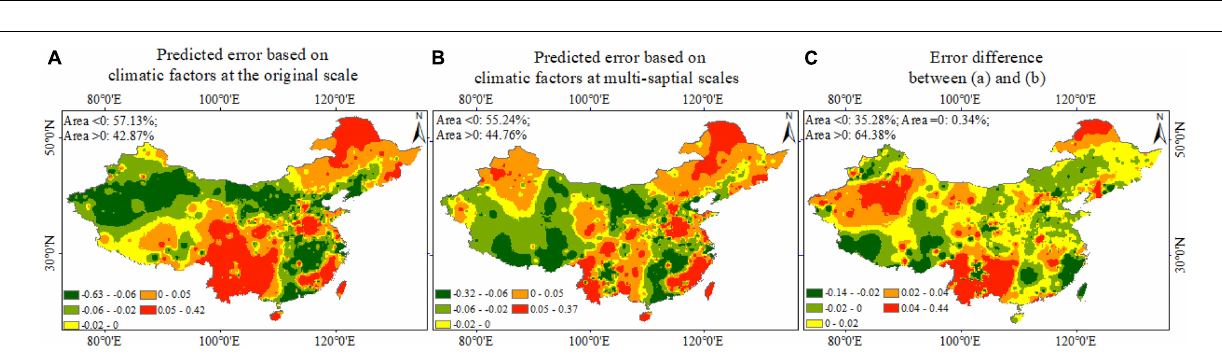
FIGURE 8 | Spatial distribution of predicted error based on climatic factors using SMLR (A) at the original scale, (B) at multi-spatial scales, and (C) error difference between (A,B) . SMLR, stepwise multiple linear